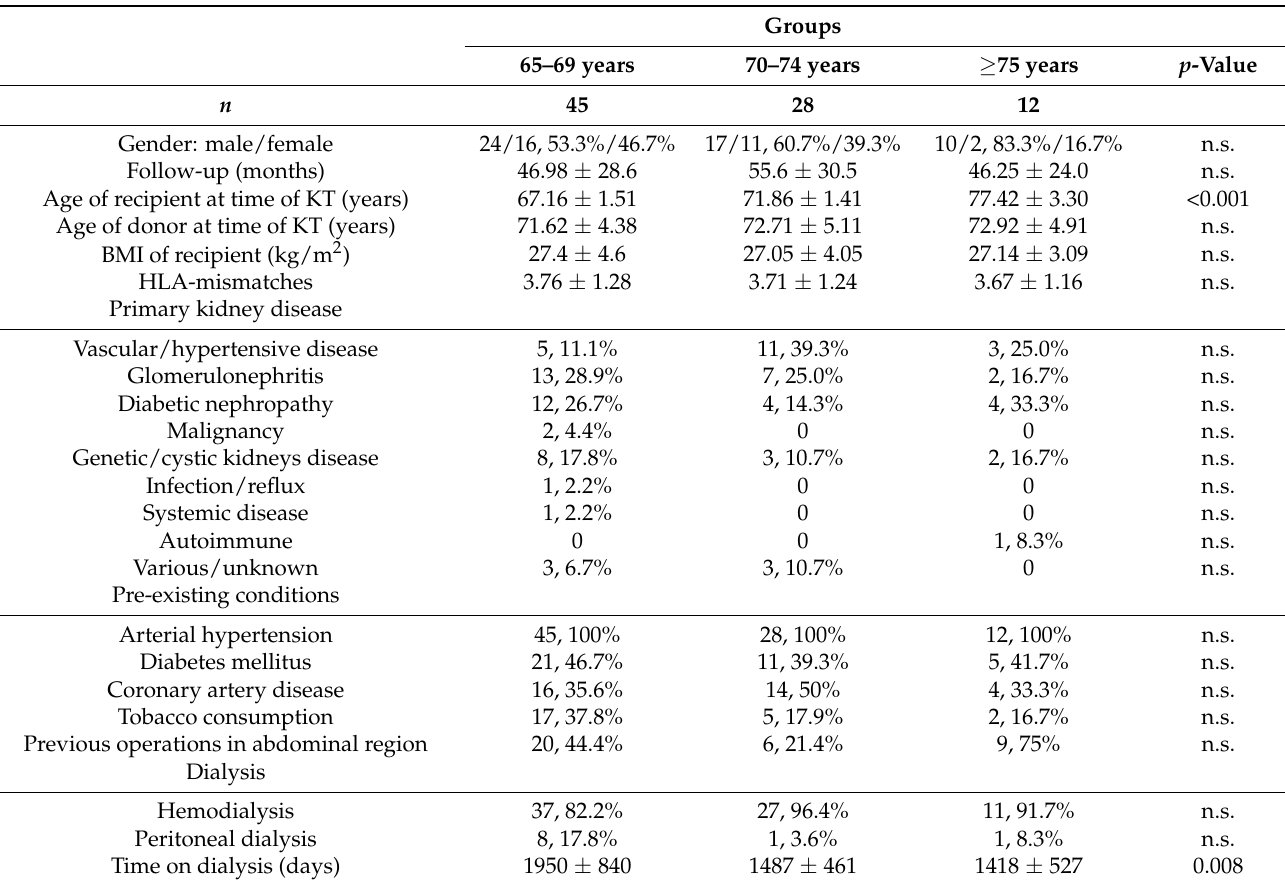
Table 1. Patient